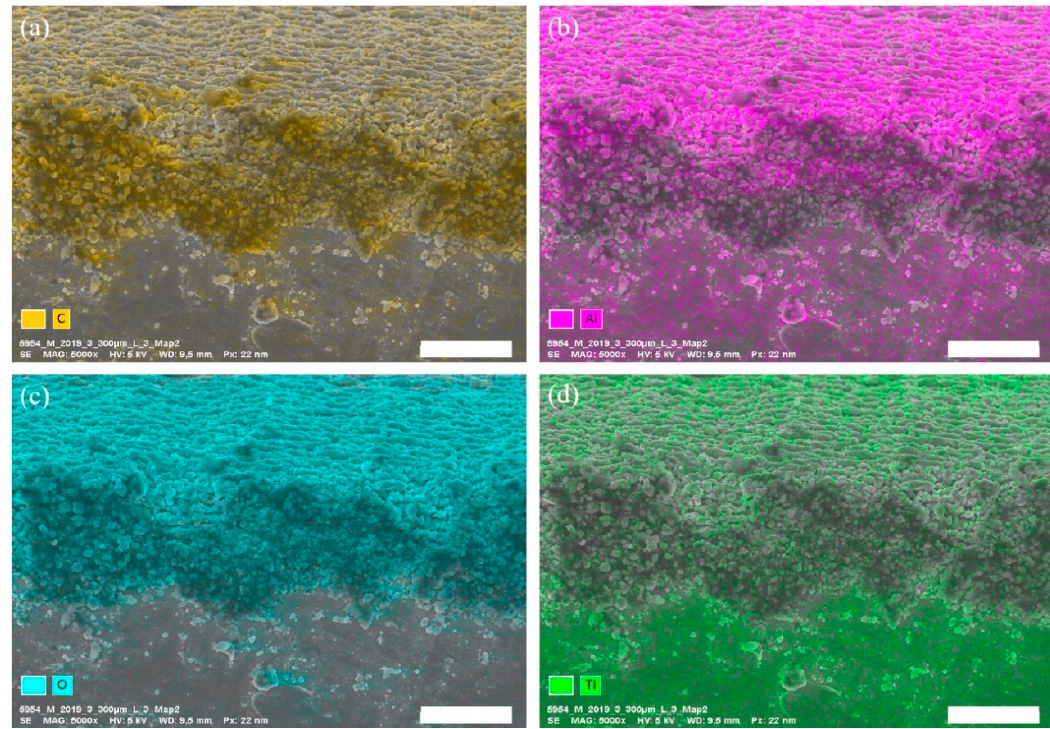
Figure 6. EDX mapping of the gap edges after 15 days of laser treatment with a 300-µm strut width (scale bar: 3 µ m). Mapping of ( a ) carbon, ( b ) aluminum, ( c ) oxygen, and ( d ) titanium.